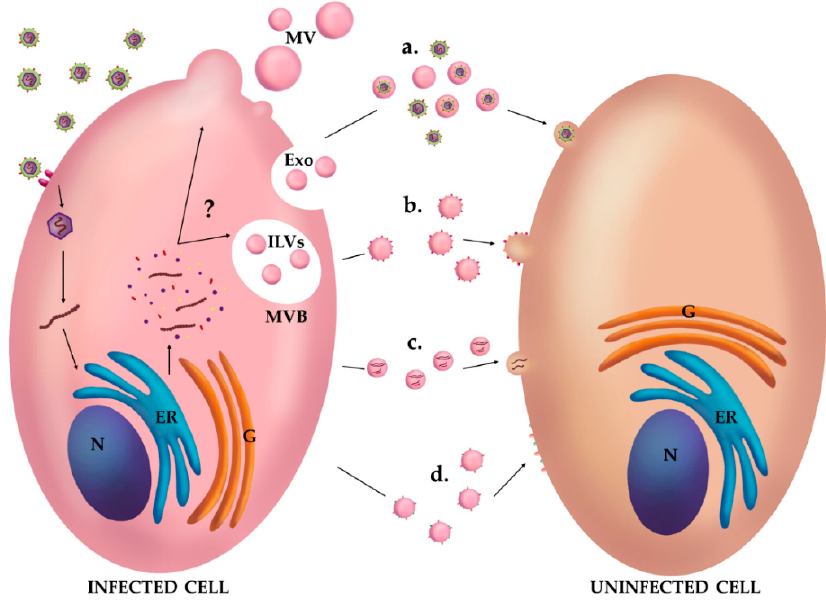
Figure 1. EVs are vehicles for the communication between infected and uninfected cells. During viral infections, virus enters cells and exploits the vesicular biogenesis machinery to release EVs, microvesicles (MV) and exosomes (Exo) with a modified composition to favor its own pathogenesis. EVs can carry ( a ) entire viral particles; ( b ) different viral proteins, such as the envelope ones; ( c ) nucleic acids including viral genomes, microRNAs and small non-coding RNAs and ( d ) host cell proteins, whose production is induced by the virus. Finally, EVs are internalized through different mechanisms and their luminal content released into the cytosol of the recipient cells. Nucleus (N); endoplasmic reticulum (ER); Golgi complex (G); multivesicular bodies (MVB); intraluminal vesicles (ILVs).